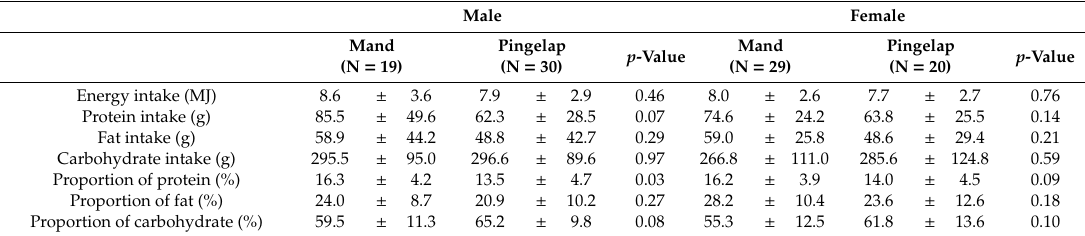
Table 4. Comparison of the estimated nutrition intake from 24-h dietary recall between two communities separately for males and females (mean ±